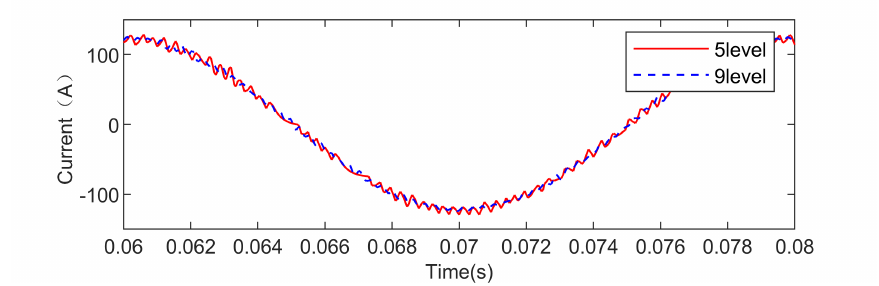
Figure 13. Output current ( i oa ) waveforms.